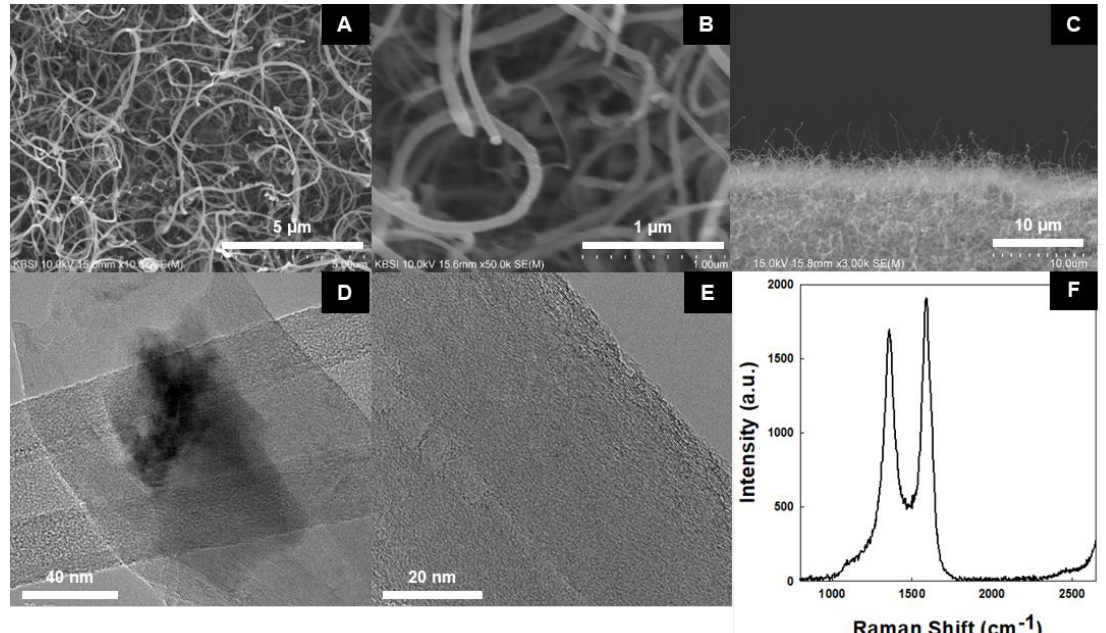
Figure 3. ( A , B ) SEM images of CNTs grown on metal substrate synthesized by PECVD; ( C ) lateral SEM Image ( D ) and ( E ) TEM image of CNTs; ( F ) Raman spectrum of